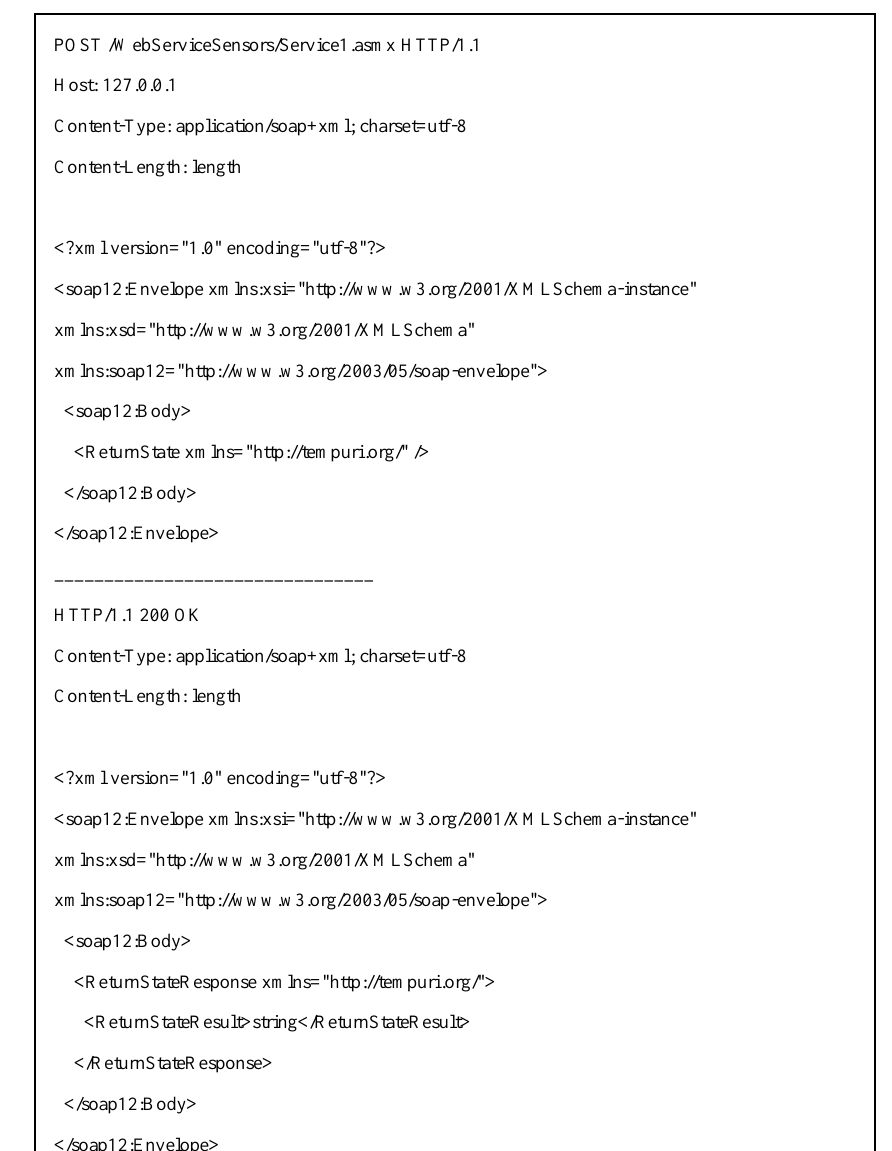
Figure 7. Example of SOAP request and